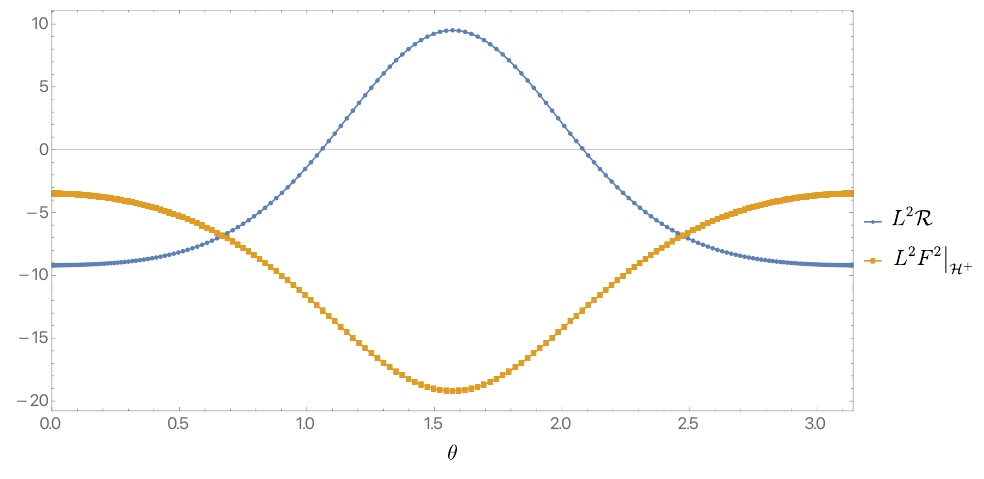
Figure 6 . R and F 2 on the horizon, as a function of θ for Q ≈ 100 . 523